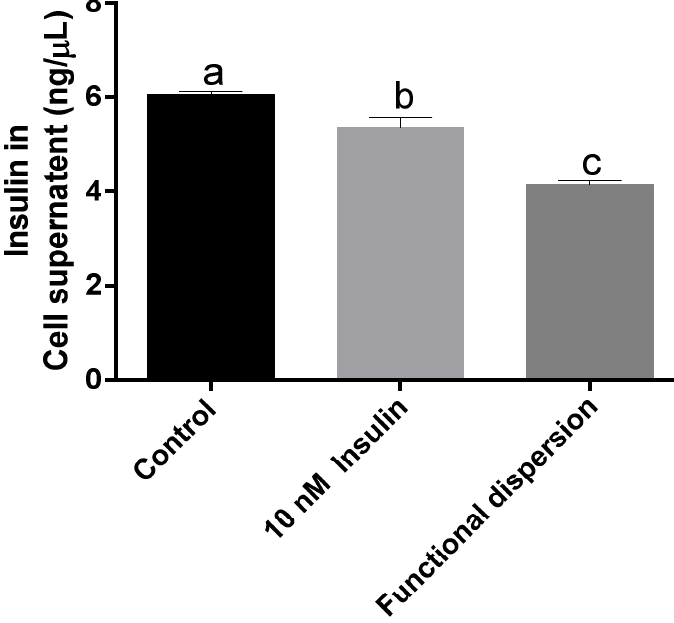
Figure 5. The amount of insulin in the cell supernatant of rat L6 skeletal muscle cell lines alone, and cells given 10 nM insulin and treated with functional dispersion for 24. Means with different letters are significantly different at p < 0.05 calculated using the two-tailed unpaired t -test. All data are represented as the mean ± S.D. of triplicates.